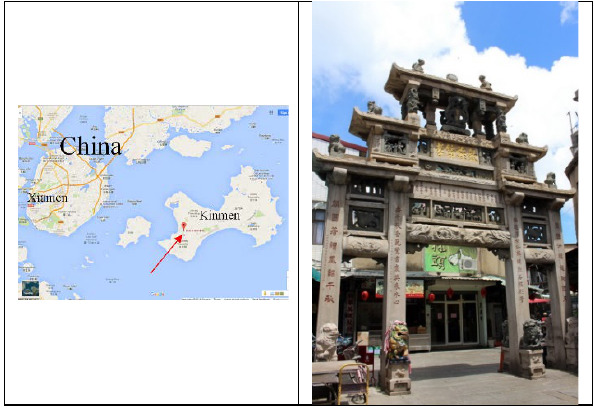
Fig. 2. Geological Location of Qiu Lian-gung's Mother Chastity Arch in Kinmen (the left, selected from Google Map), Photo (the